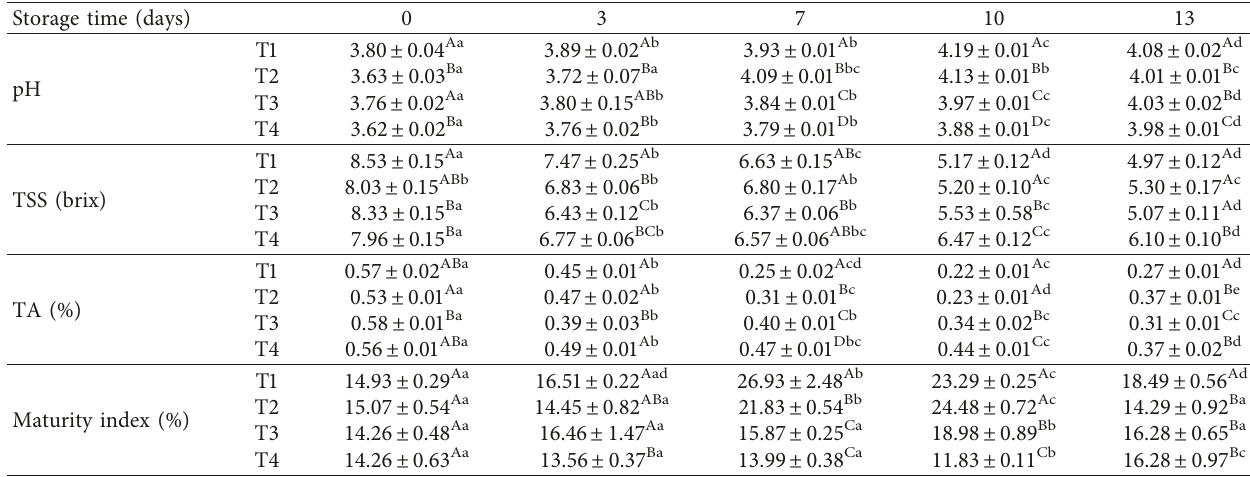
Table 1: pH, total soluble solids (TSS), titratable acidity (TA), and maturity index (MI) of coated and uncoated strawberries during storage at 4 ° C for 13 days.